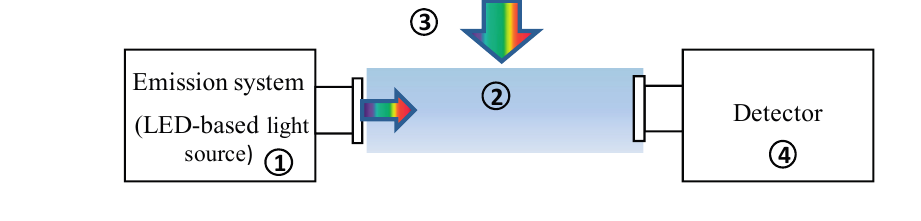
Figure 3. Sources of uncertainties in LED-based hyperspectral